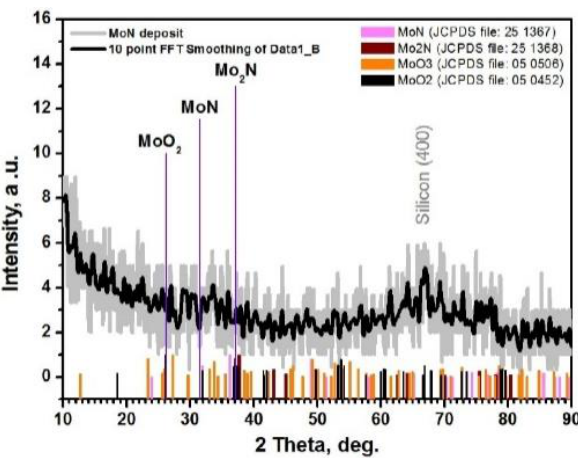
Fig. 6. X-ray diffraction spectrum of MoN